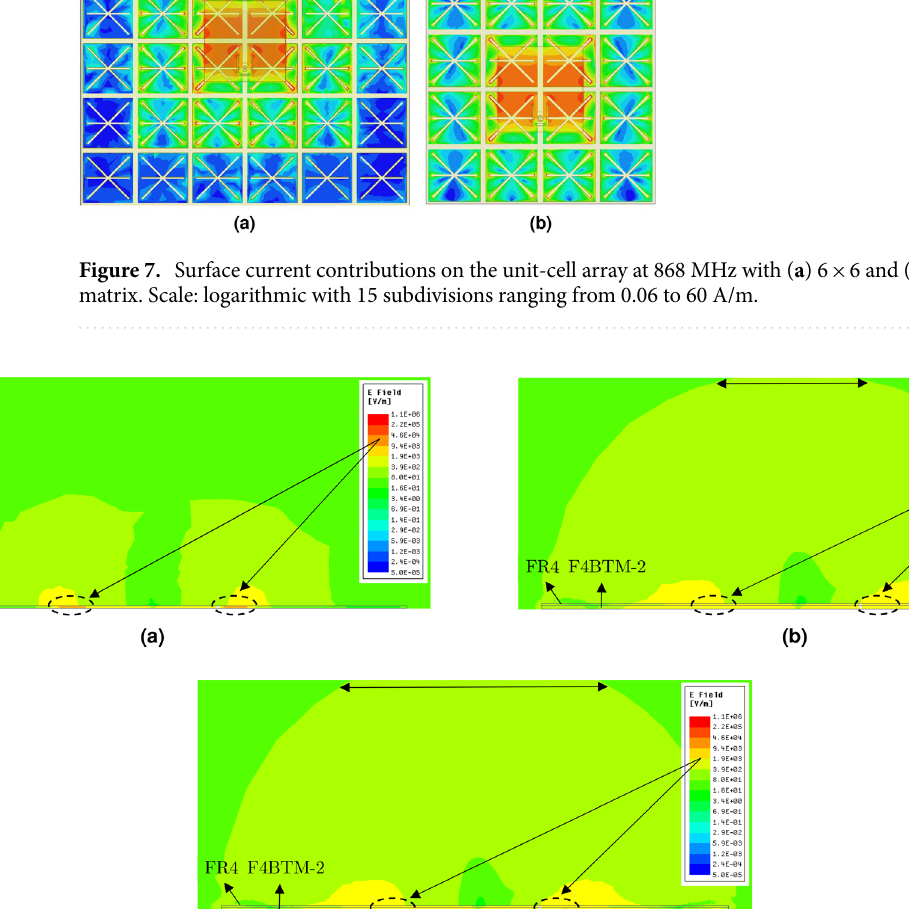
Figure 8. E-field distributions on the x – z plane for 1 W input power at 868 MHz produced by a: ( a ) typical patch, ( b ) proposed MPA, ( c ) similar to ( b ) with lossless